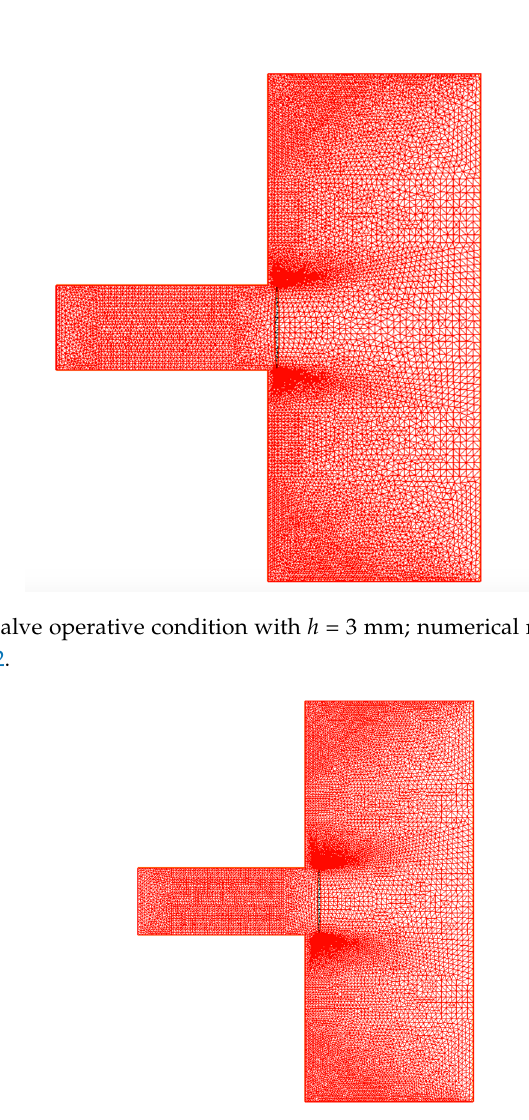
Figure 6. Case 1: valve operative condition with h = 3 mm, with velocity vertical component v .